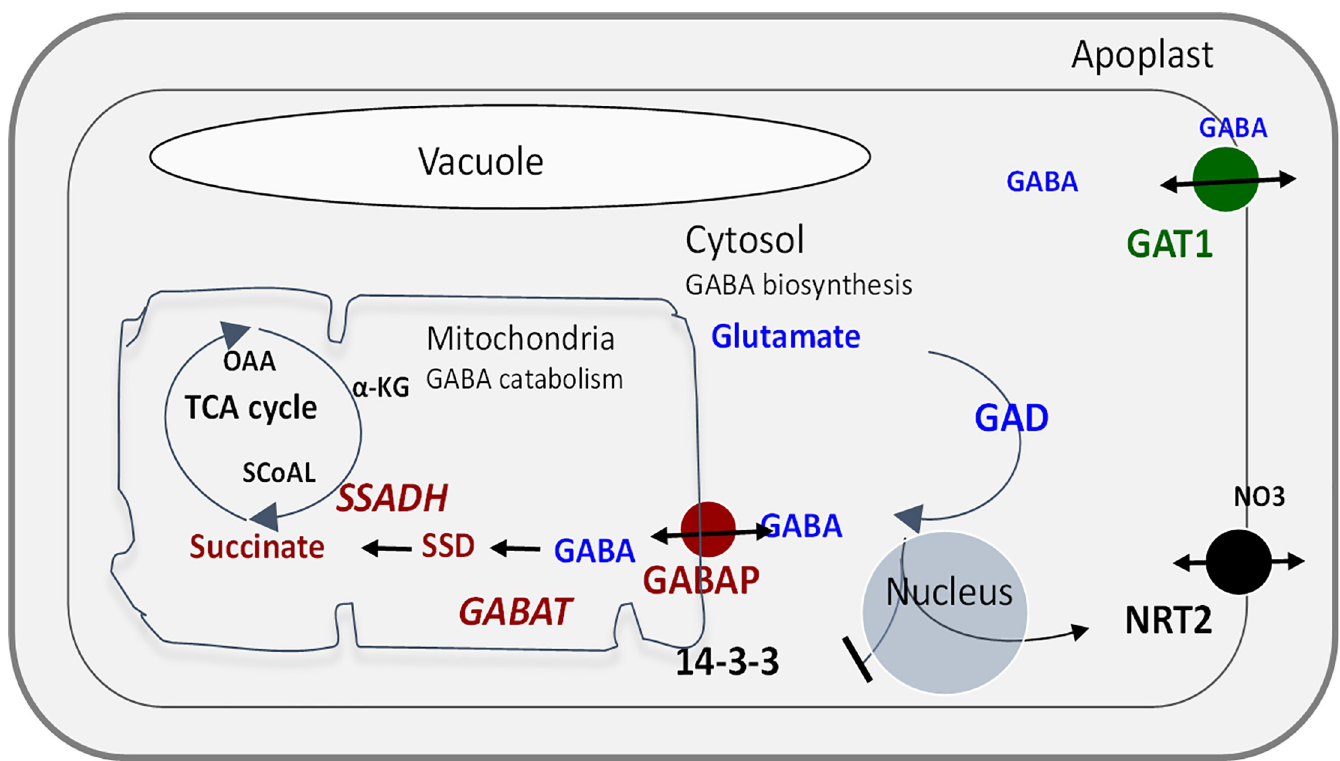
Fig 1. GABA biosynthesis, transport, and metabolism. All abbreviations are defined in Table 1 except, OAA, 2-oxaloacetate; NRT2, nitrate transporter.